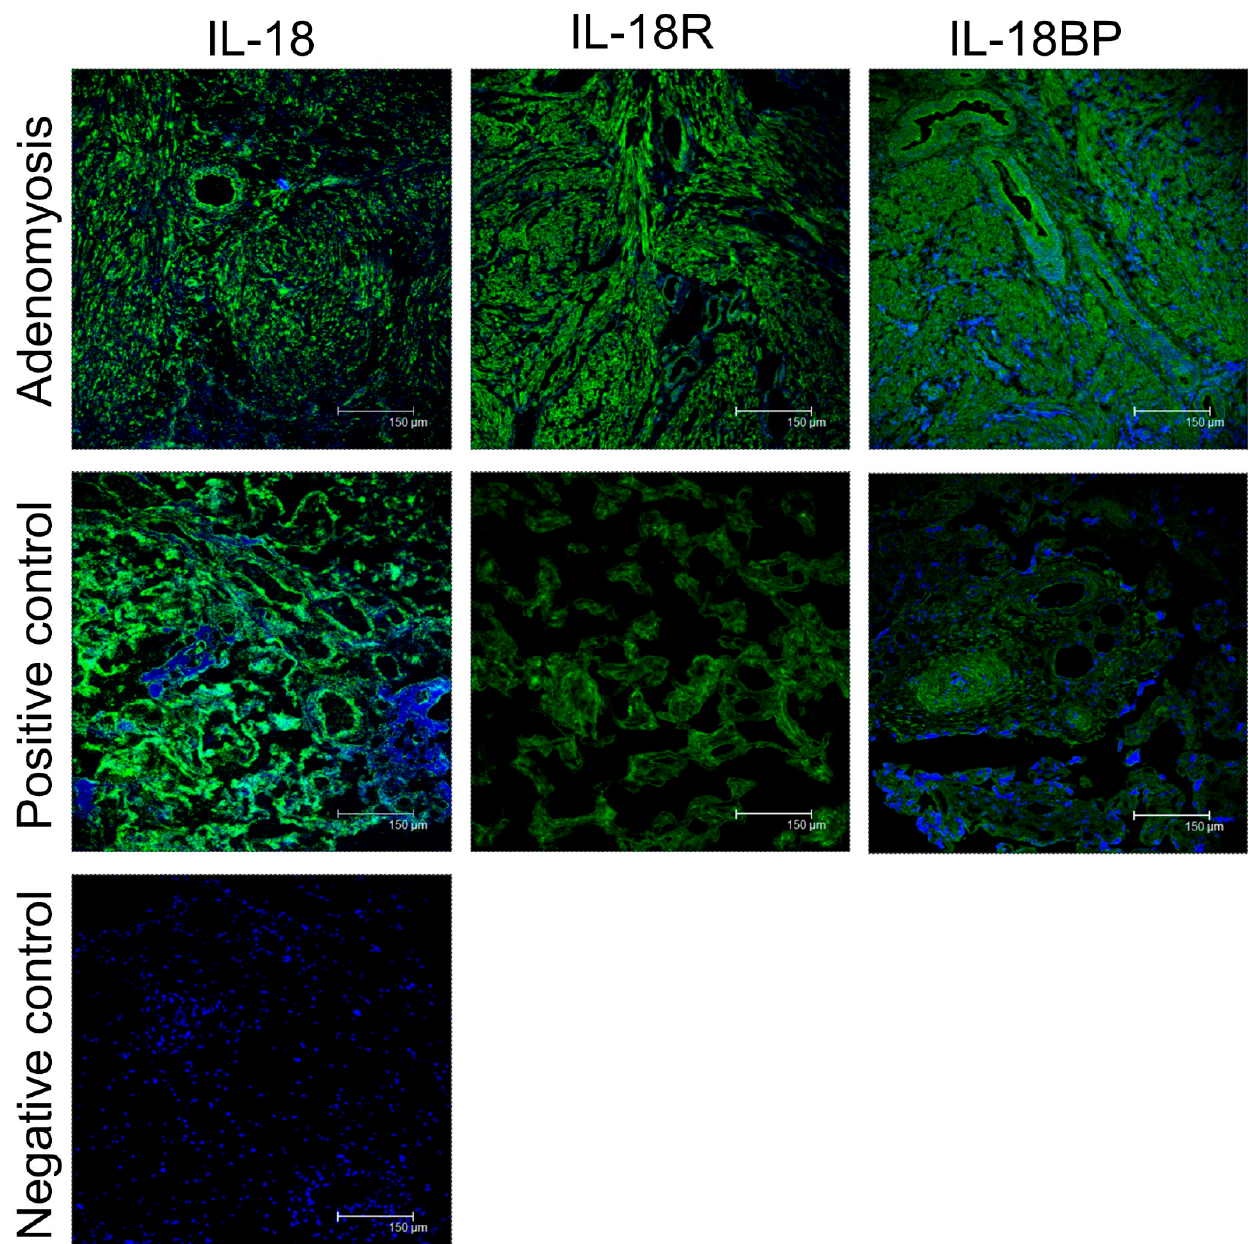
Figure 3. Immunofluorescence of IL-18 system in patients with adenomyosis. The expression of IL-18 system (green) is located in the cytoplasm of both glandular and stromal cells. The human placenta was a positive control of IL-18. The study samples from patients with adenomyosis showed significant overexpression of IL-18 system proteins, indicating the presence of IL-18 system may act as a local immunomodulator in adenomyosis. Scale bars = 150 μ m.